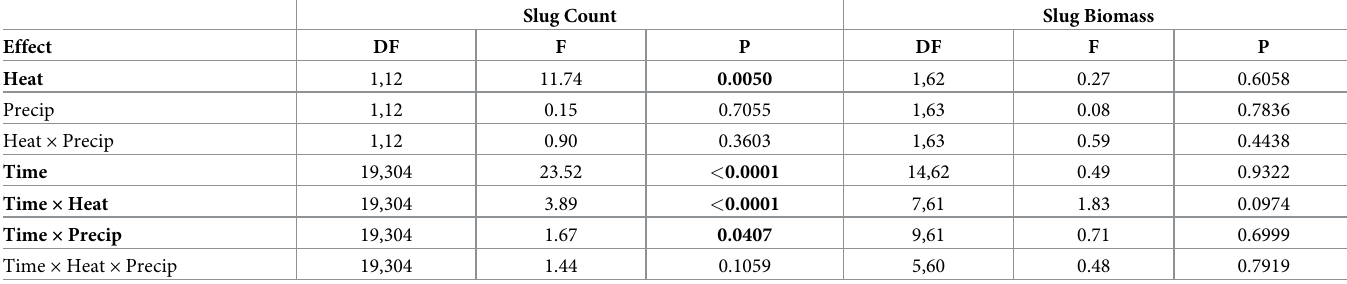
Table 3. ANOVA table for the average count and biomass of slugs trapped per plot for 2013 in the climate change treatments. Degrees of freedom are numerator, denominator. Bolding indicates significance.